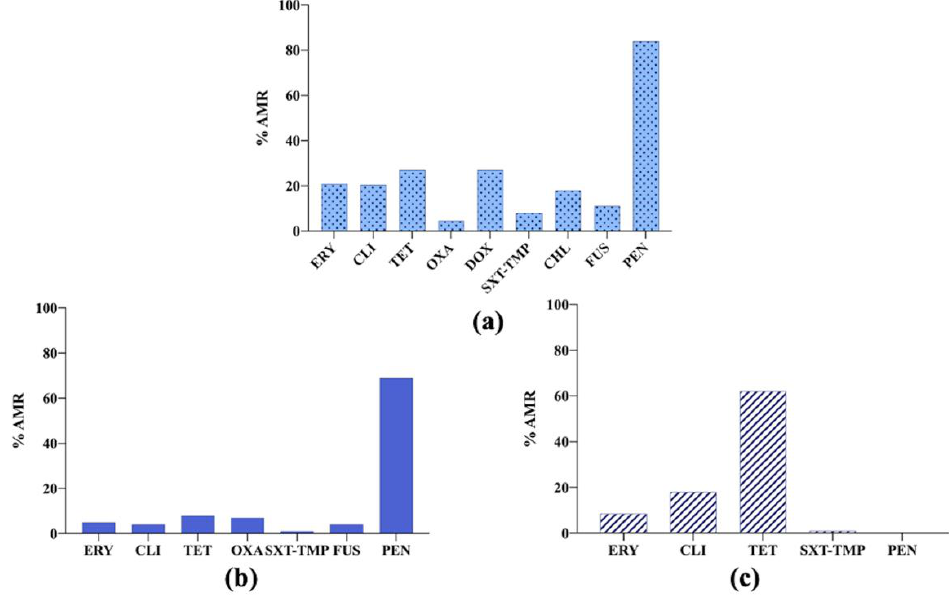
Figure 4. ( a ) Antimicrobial resistance (AMR) prevalence in Staphylococcus pseudintermedius isolated from dogs in Finland. ERY: erythromycin; CLI: clindamycin; TET: tetracycline; OXA: oxacillin; DOX: doxycycline; SXT-TMP: sulfamethoxazole – trimethoprim; CHL: chloramphenicol; FUS: fusidic acid; PEN: penicillin. ( b ) Antimicrobial resistance (AMR) prevalence in Staphylococcus aureus isolated from dogs in Finland. ERY: erythromycin; CLI: clindamycin; TET: tetracycline; OXA: oxacillin; SXT- TMP: sulfamethoxazole – trimethoprim; FUS: fusidic acid; PEN: penicillin. ( c ) Antimicrobial